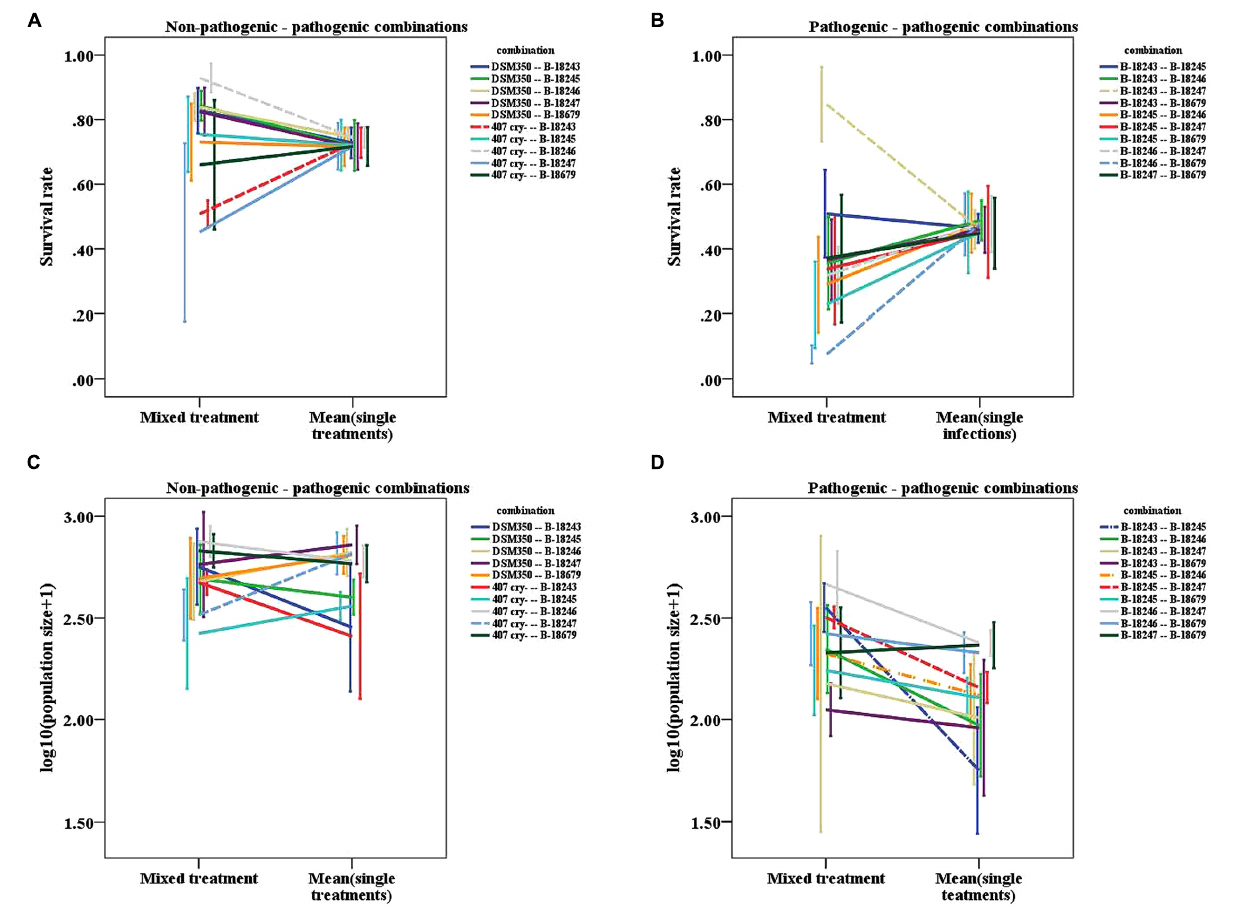
size of the pathogenic mixed treatment. Dashed lines represent combinations, for which the slope differs significantly from zero, dashed-dotted lines represent combinations, for which the slope shows a tendency to differ from zero. Vertical lines represent the onefold standard